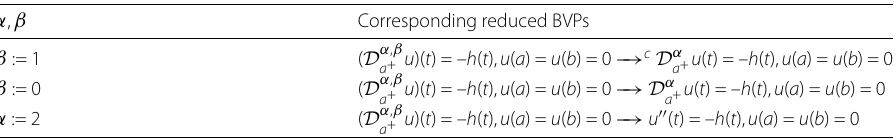
Table 1 Advantage of using the Hilfer fractional derivatives α , β Corresponding reduced BVPs β :=